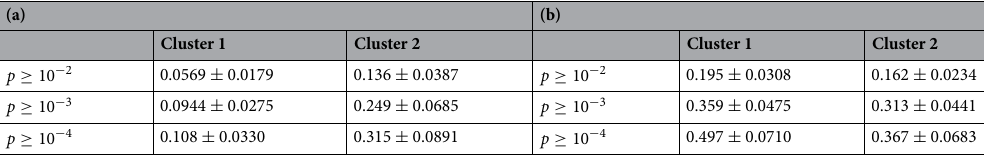
Table 4. Rates of trends within clusters, which are generated from the unimodal Gaussian distribution. We investigated whether the p values of the Shapiro–Wilk test for the trends are greater than the thresholds. The number of clusters and B were set to 2 and 6 as in the proposed GLIPCA. We performed experiments 10 times with different initialization values and show the average and standard deviation. (a) Results for k -shape 32 . (b) Results for k -shape 32 with the graphical lasso algorithm 22 . ρ was set to 0.015 as in GLIPCA.